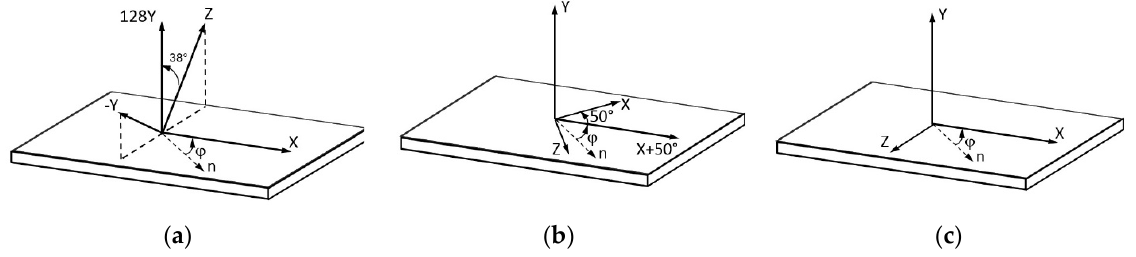
Figure 2. Crystallographic orientation of LiNbO 3 plates analyzed in the paper ( a ) 128 YX, ( b ) Y − X + 50 ◦ , and ( c ) YX. n is wave propagation direction.